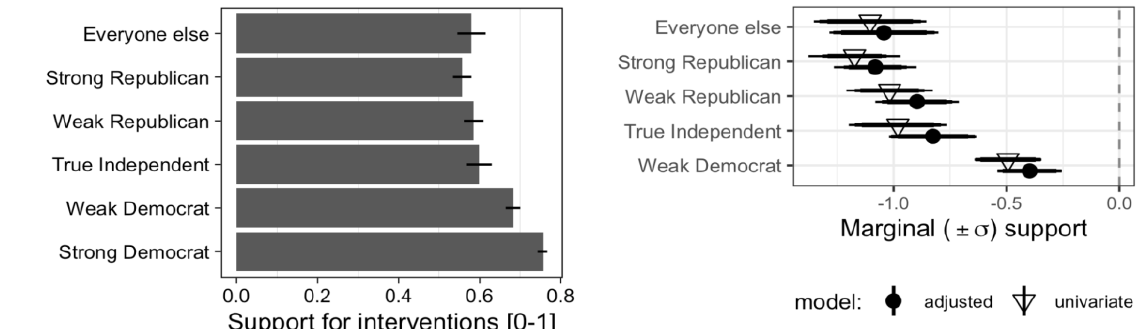
Figure 3. Support for misinformation interventions (overall index) by party. The plot on the left shows the mean and ±1.96 standard errors of aggregate support (index rescaled to 0-1) by respondent group in the 6-point partisan identification scale; the plot on the right visualizes the standardized marginal differences (relative to Strong Democrat) in support between partisan groups using a simple t